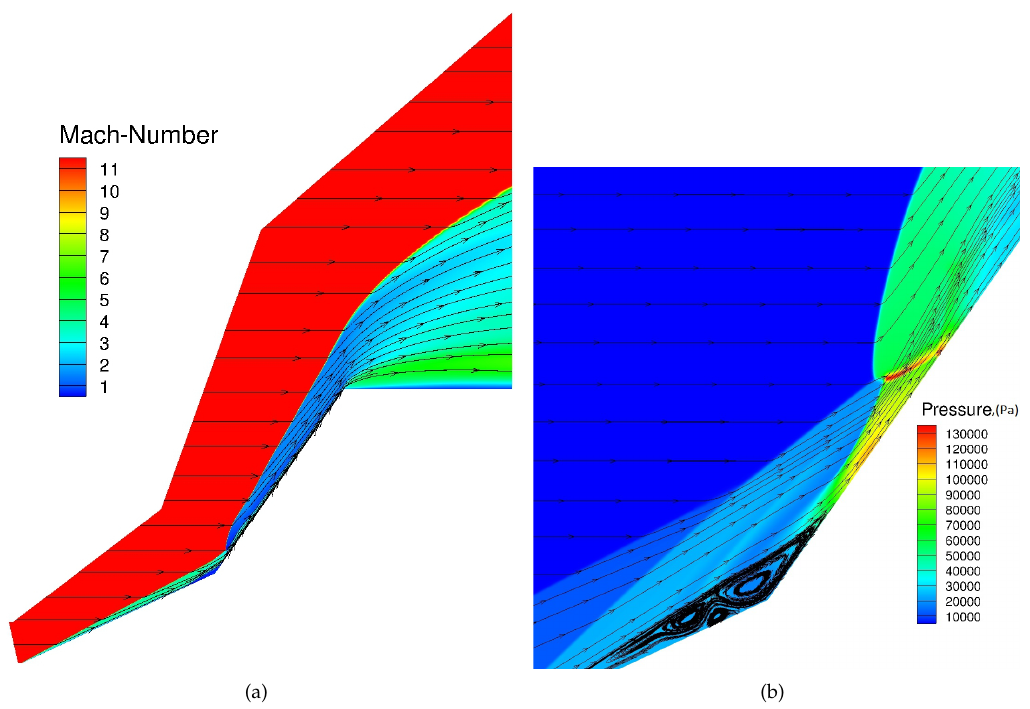
Figure 10. Flow field structure for Run 6, Table 1, using the non-equilibrium Navier–Stokes model. ( a ) Overall flow field; ( b ) Enlargement of flow